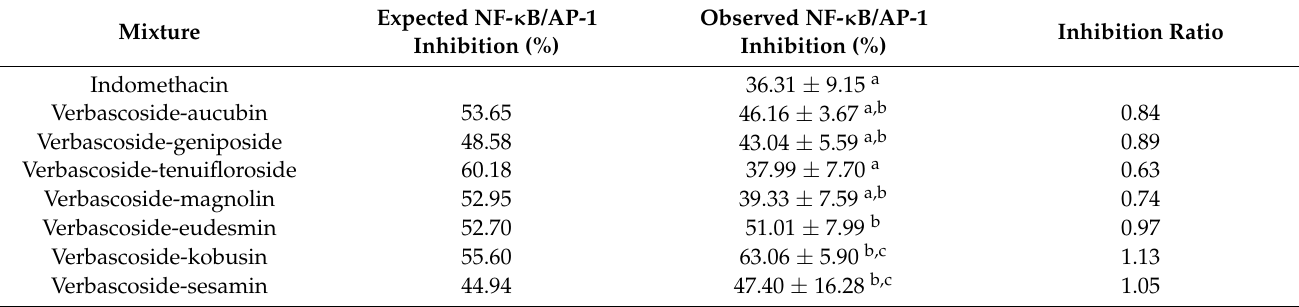
Table 2. NF- κ B/AP-1 inhibitory activity on RAW-Blue™ cells of binary mixtures using verbascoside as a leader compound.